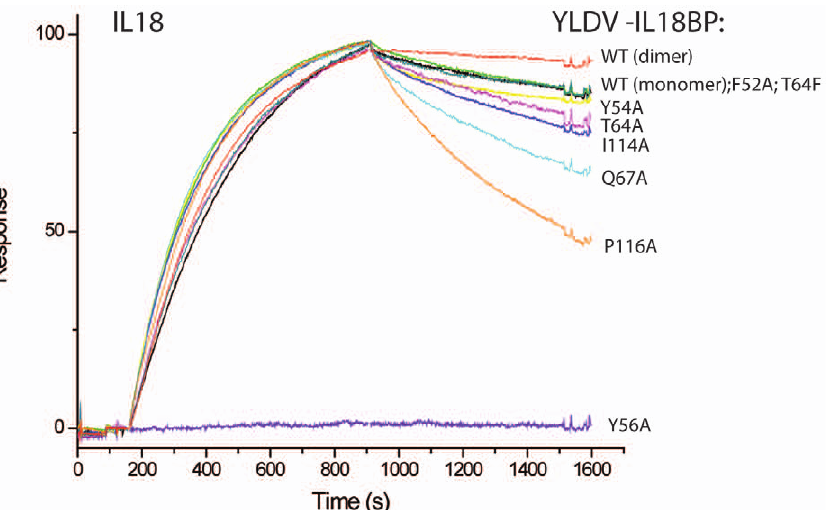
Figure 7. Biacore SPR Analysis of YLDV-IL18BP mutants. Biotinylated IL18 was captured on a BIAcore streptavidin-coated CM5 chip, and its binding with IL18BP was monitored with a BIAcore 3000 sensor. All the YLDV-IL18BP proteins were expressed in E. coli as SUMO fusion and purified to near homogeneity. The IL18BP mutants were derived from the monomeric form of the protein with the HVEC mutation. The injection of IL18BP started at , 150 s and stopped at 900 s. The colored lines are the responses obtained with different IL18BP mutants and normalized to a maximum of 100 resonance units (RU) (except for Y56A) for ease of comparison.